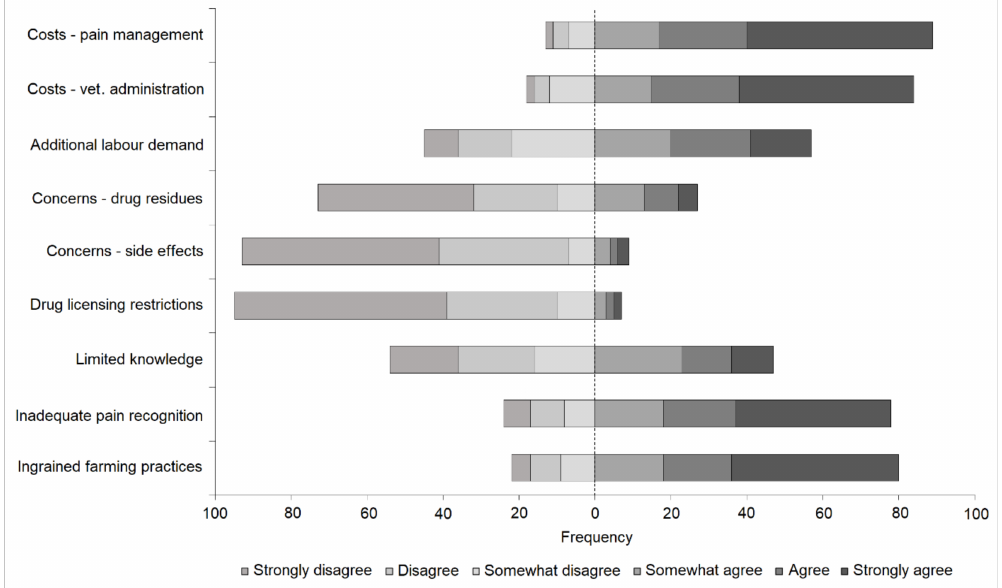
Figure 2. The number of veterinarians that perceived certain factors as barriers to the provision of pain management on-farm, where the dashed line represents the point between disagreement and agreement based on responses to a 6-point Likert-type